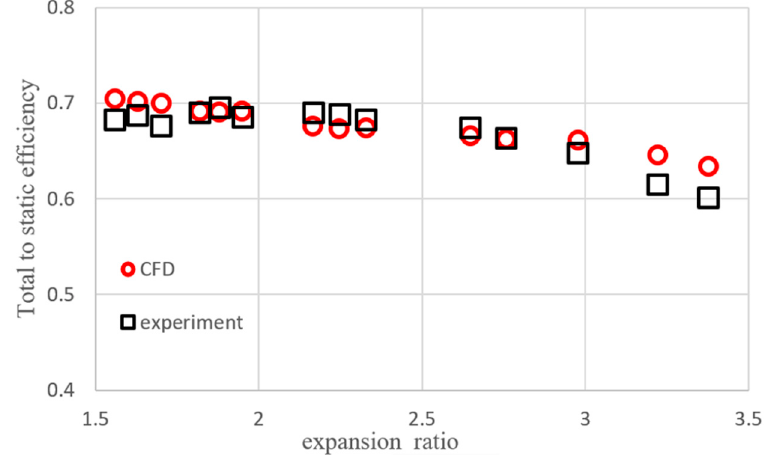
Figure 5. The total to static efficiency vs. expansion ratio.